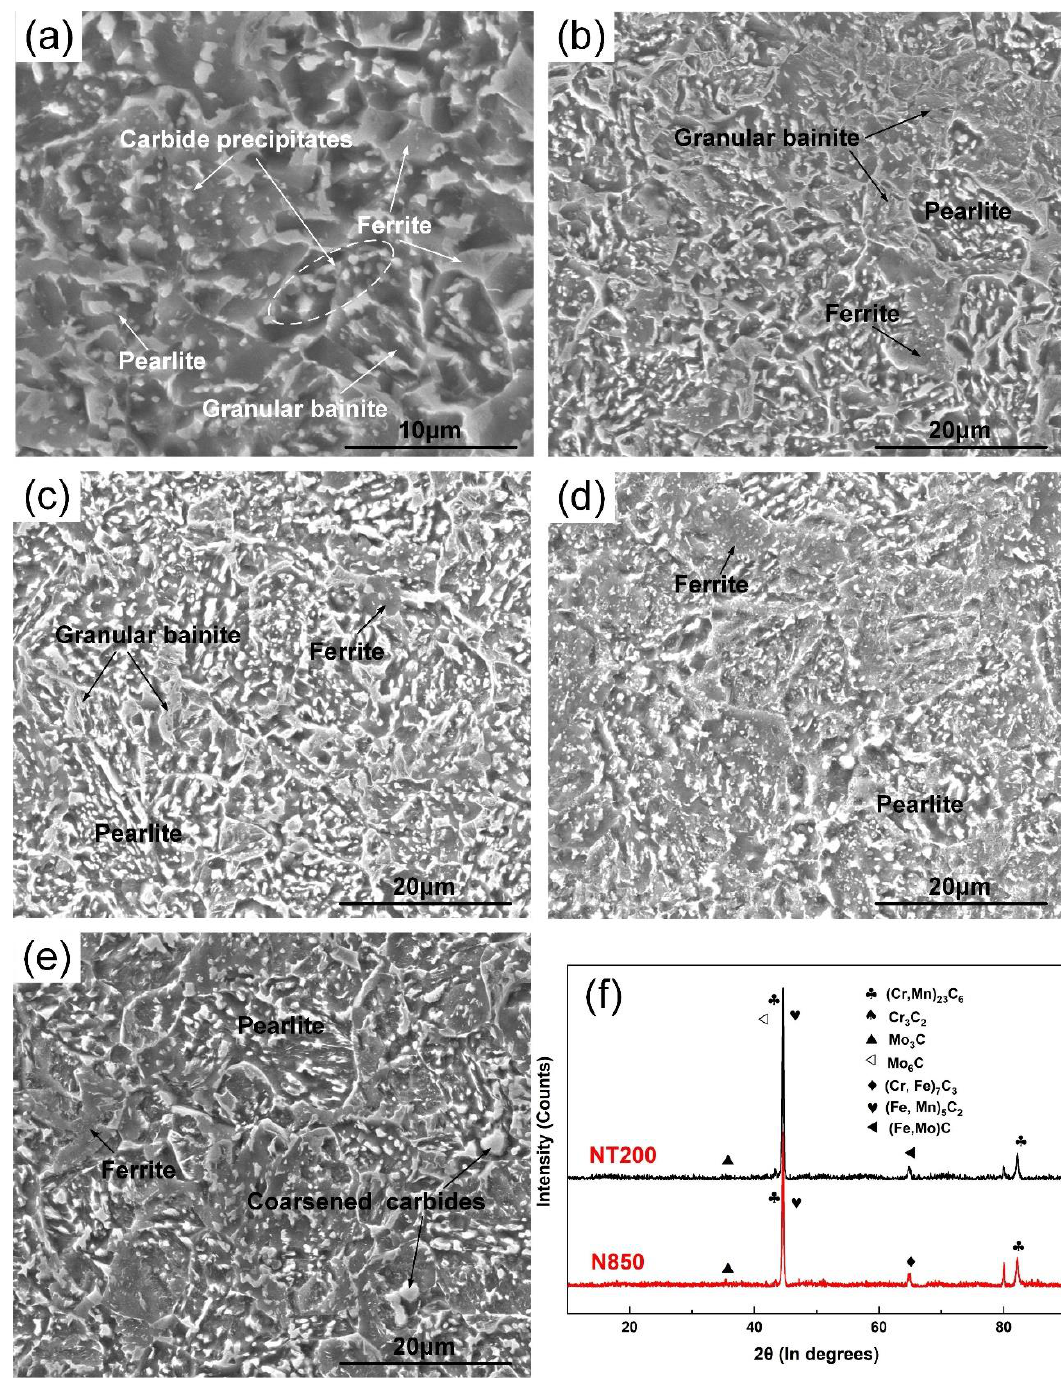
Figure 11. Effect of different tempering temperature on microstructure of normalized sample: ( a ) no Figure 11. E ff ect of di ff erent tempering temperature on microstructure of normalized sample: ( a ) no tempering (N850), ( b ) at 200 °C (NT200), ( c ) at 350 °C (NT350), ( d ) at 550 °C (NT550), ( e ) at 850 °C tempering (N850), ( b ) at 200 ◦ C (NT200), ( c ) at 350 ◦ C (NT350), ( d ) at 550 ◦ C (NT550), ( e ) at 850 ◦ C (NT850); ( f ) X-ray diffraction (XRD) patterns under N850 and NT200 states. (NT850); ( f ) X-ray di ff raction (XRD) patterns under N850 and NT200